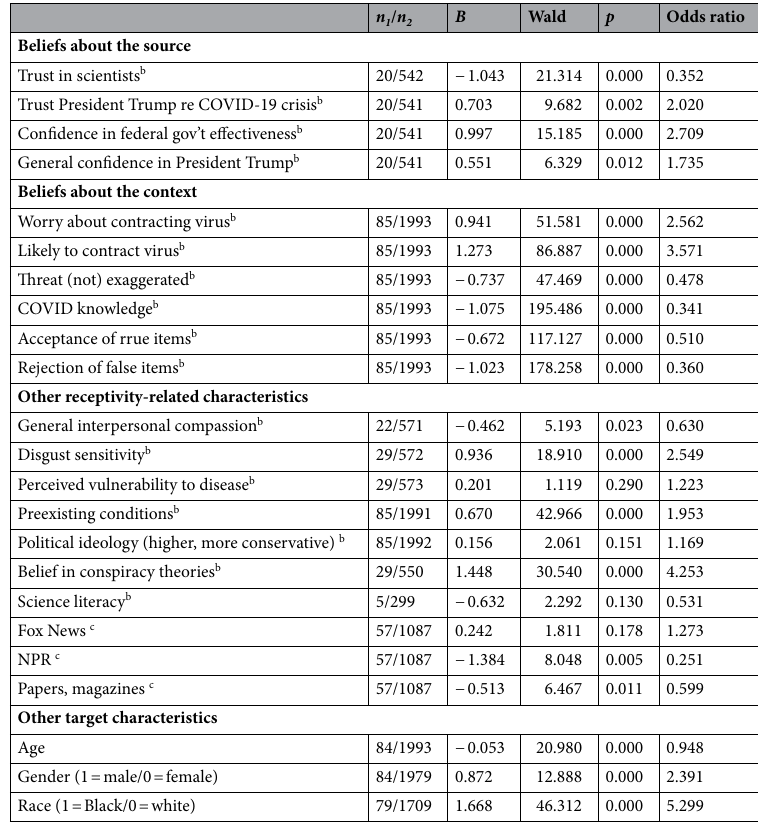
Table 1. Predicting positive COVID-19 test a . a Coded 0 = Negative Test Result or Untested ( n 2 ), 1 = Positive Test Result ( n 1 ). b Standardized. c Coded 0 = neither watch last week, nor primary news source, 1 = watched last week or primary, 2 =